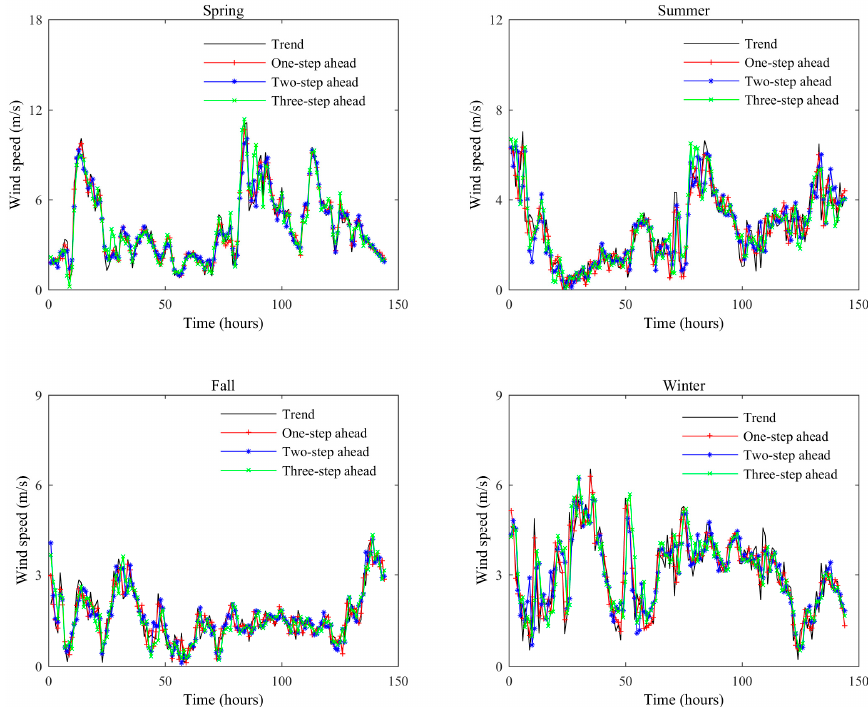
Figure 9. Multi ‐ step ahead prediction results of trend component in four cases. Figure 9. Multi-step ahead prediction results of trend component in four